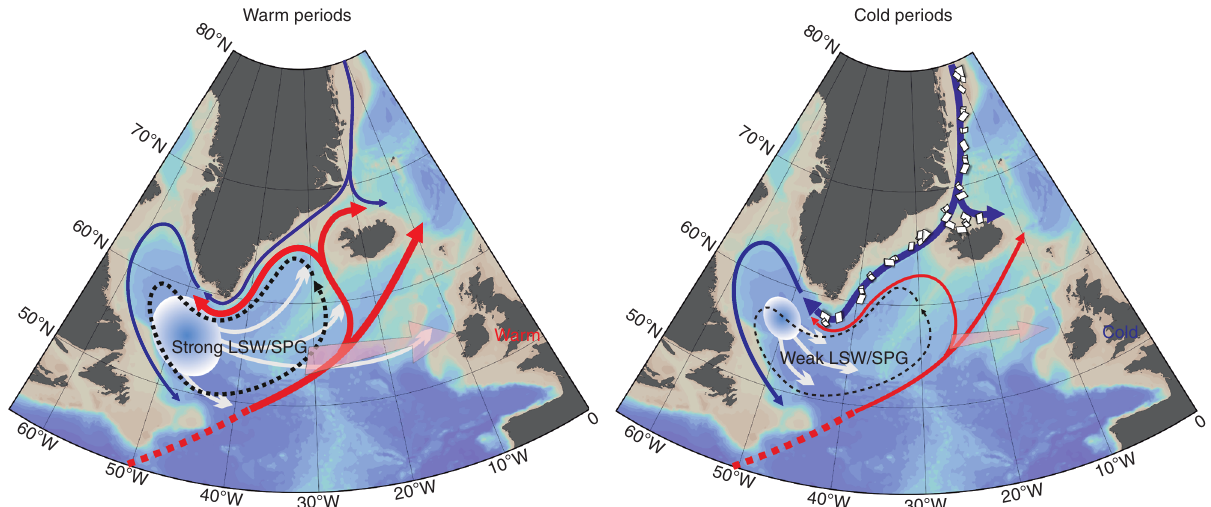
Fig. 5 Schematic of the ocean circulation patterns during centennial warm and cold periods. The Atlantic waters (from the North Atlantic Current and the IC) and Polar Waters (EGC) are represented in red and blue arrows, respectively with the thickness of the lines representing the contribution at the northern boundary of the Subpolar Gyre (SPG) and transport. The black dotted lines indicate the SPG and the white circle and the arrows indicate the formation and spreading of LSW. The faded pink arrow represents the heat transport towards Europe in each scenario. Bathymetric basemap made using ODV (Schlitzer, R., Ocean Data View, https://odv.awi.de,